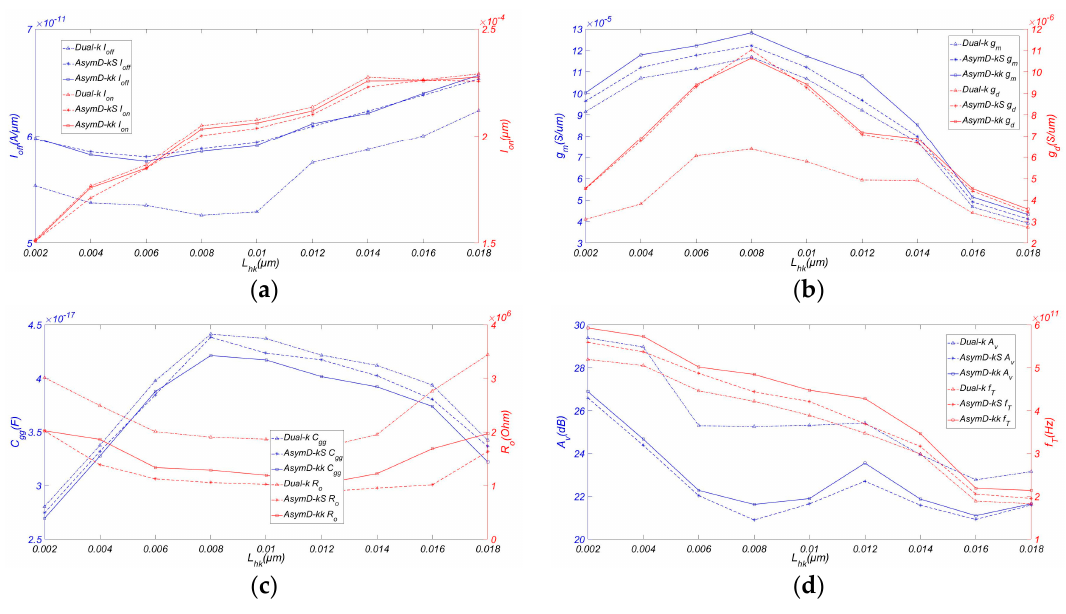
Figure 6. Variation of ( a ) I off and I on , ( b ) g m and g ds , ( c ) C gg and R o , ( d ) A v and f T of FinFET with L hk . Simulated with H fin = 15 nm, W fin = 6 nm, T ox = 0.8 nm, L ext = 20 nm, σ L = 3 nm, and V ds = 0.9 V.